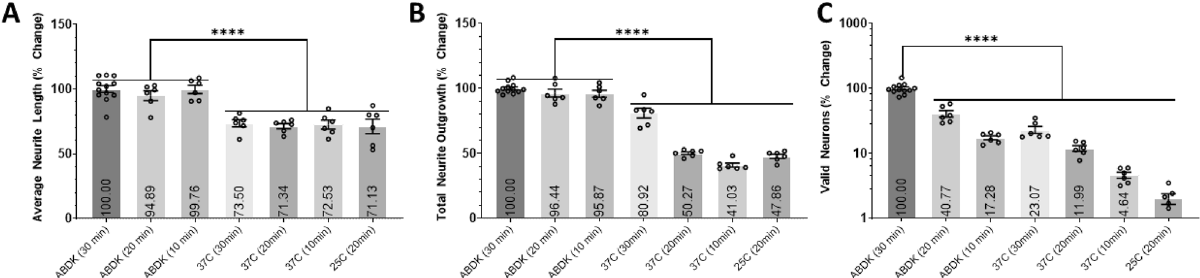
Figure 2. The effects of different dissociation protocols, timing, and temperature. Histograms of the ( A ) average neurite length, ( B ) total neurite outgrowth, and ( C ) number of valid neurons expressed as percent change relative to the standard gentleMACS Program 37C_ABDK_01 protocol (ABDK (30 min)). Data analyzed using one-way ANOVA with Dunnett’s post-hoc test comparing the mean of each condition to the mean of ABDK (30 min). In parentheses represents the length of the protocol whether being ran on the gentleMACS™ Octo Dissociator with Heaters (ABDK) or in a revolving apparatus incubated at 37 °C or 25 °C. Primary cortical neurons isolated from young adult male mice and cultured for 2DIV. 6 wells per condition (n = 6). *(P < 0.05), **(P < 0.01), ***(P < 0.001), ****(P < 0.0001). Graphs show mean and